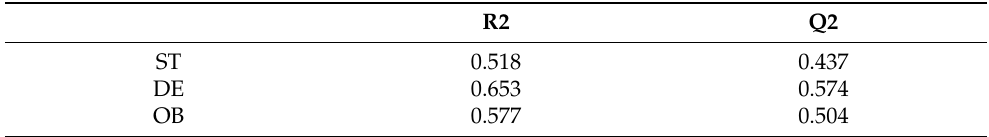
Table 8. Coefficients of determination and